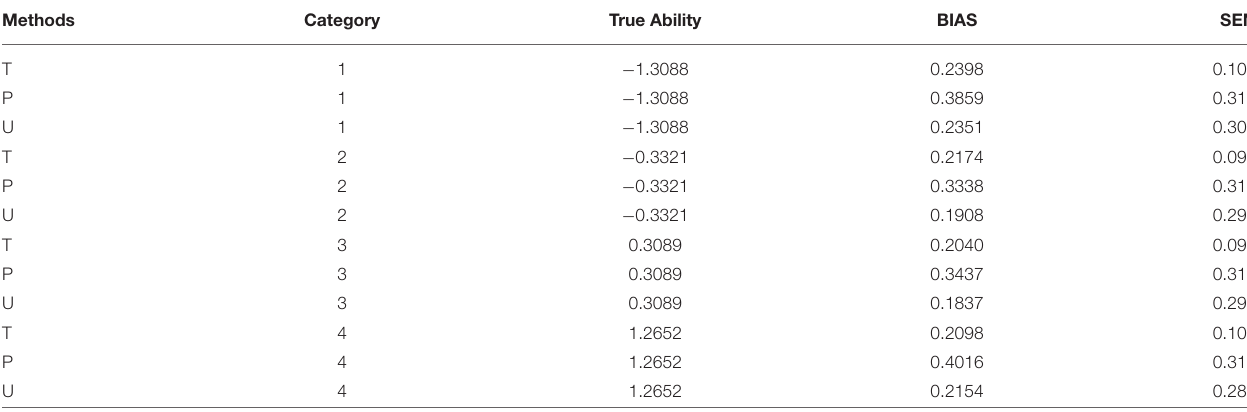
TABLE 1 | True ability, BIAS, and SEM for T, P, and U methods for test length of 30 with no item exposure control. Methods